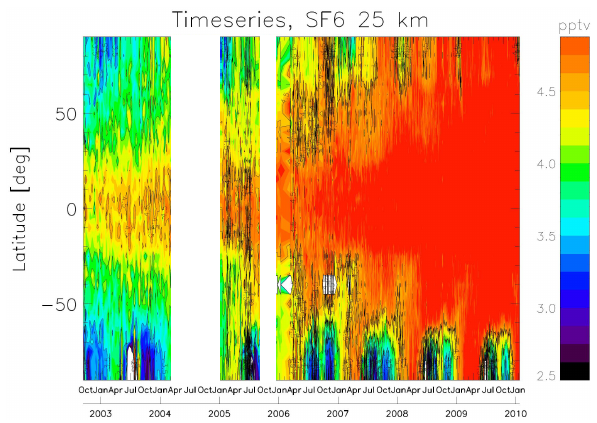
Fig. 1. Time series of SF 6 volume mixing ratio over all latitudes at 25km altitude for the period September 2002 to January 2010. The white bars indicate data gaps where no measurements were